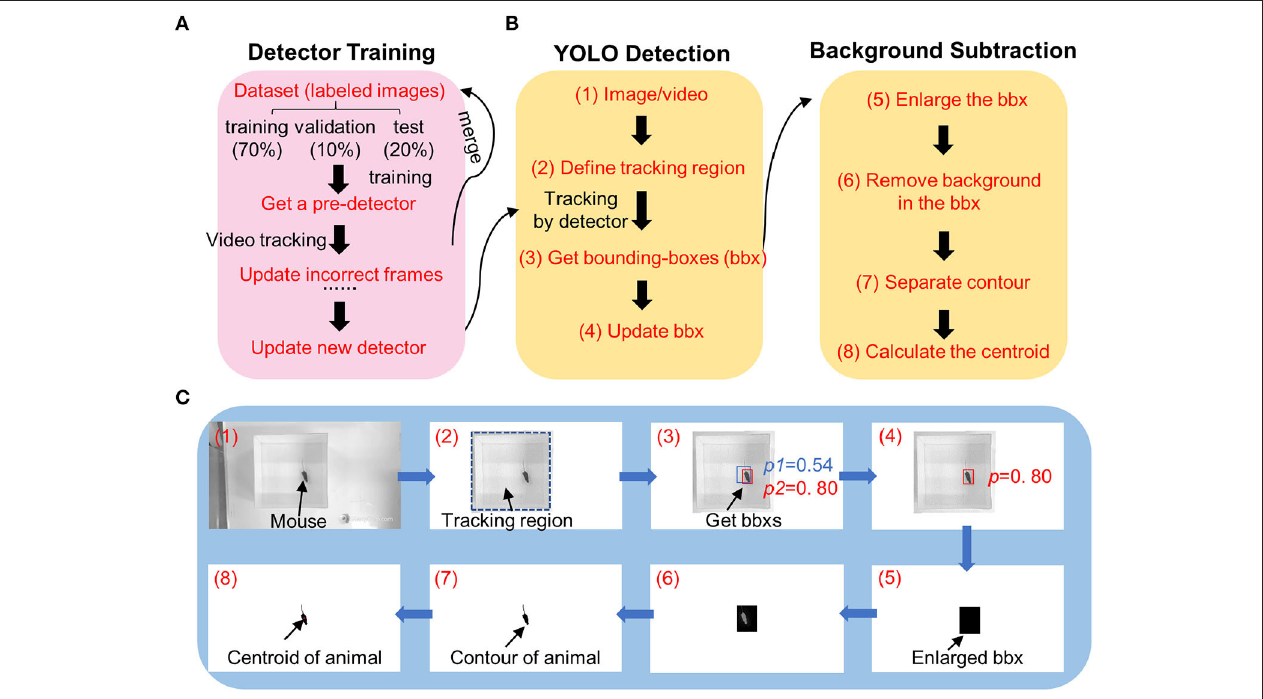
FIGURE 1 | Diagram image showing workflow of DeepBhvTracking. (A) Detector training workflow combining a pretrained deep neural network and YOLO algorithm. The parameters were updated via backpropagation. If the detector is not satisfied, wrong images were labeled, and merged into pretrained dataset for detector training again. (B) Target tracking workflow. Left, detecting the bounding box using YOLO deep learning method. Right, obtaining centroid with background subtraction method. (C) Schematic diagrams showing the tracking process of one frame from an open-field video. The numbers in C match the corresponding number in the tracking workflow of (B) .